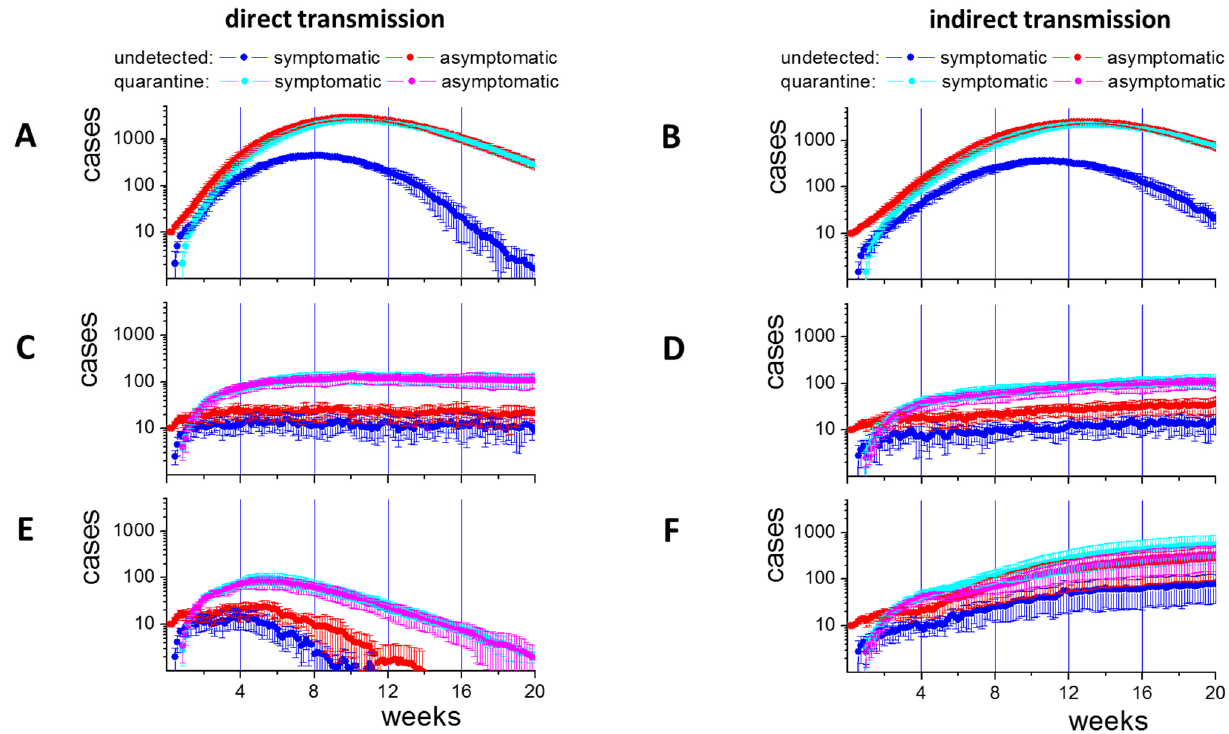
Figure 3. Epidemic spread for direct and indirect transmission. Time series of case numbers for controlled spreading without CT ( A , B ), with CT ( C , D ) and for LD after 4 weeks in parallel to CT ( E , F ). Case numbers are shown for detected and undetected symptomatic and asymptomatic cases (averages over 10 simulations, errors: sd). Without CT, case numbers peak between 8 and 13 weeks. With CT, they stabilize after short time at a much lower level. An LD20 is efficient for direct ( R eff < 1) but counterproductive ( R eff > 1) for indirect transmission. (greyscale version: see Supplementary Materials Figure S6).